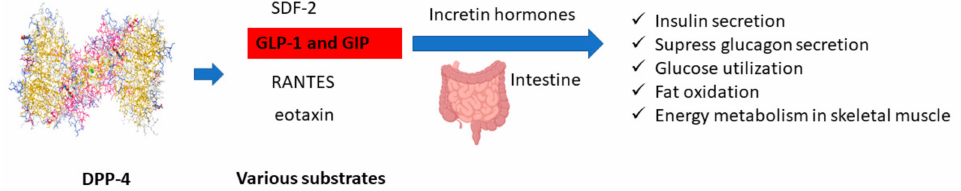
Figure 1. Potential role of protecting incretin hormone degradation by DPP-4